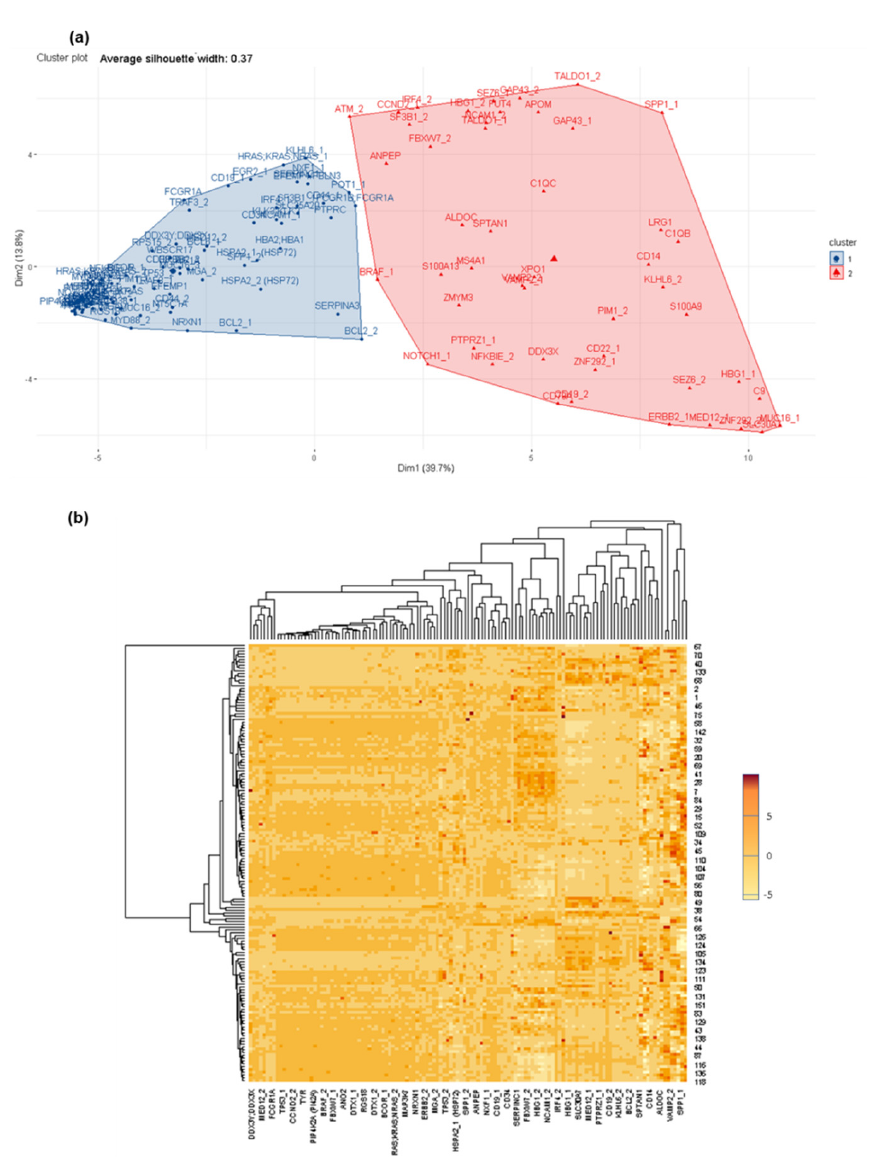
Figure 5. Differential protein profiles within CSF + LM according to primary tumor (lymphoma and leukemia). ( a ) Differential protein profiles clustered to discriminate between CSF + LM (lymphoma in contrast to leukemia). ( b ) Heat map of protein distribution identified in this comparison.